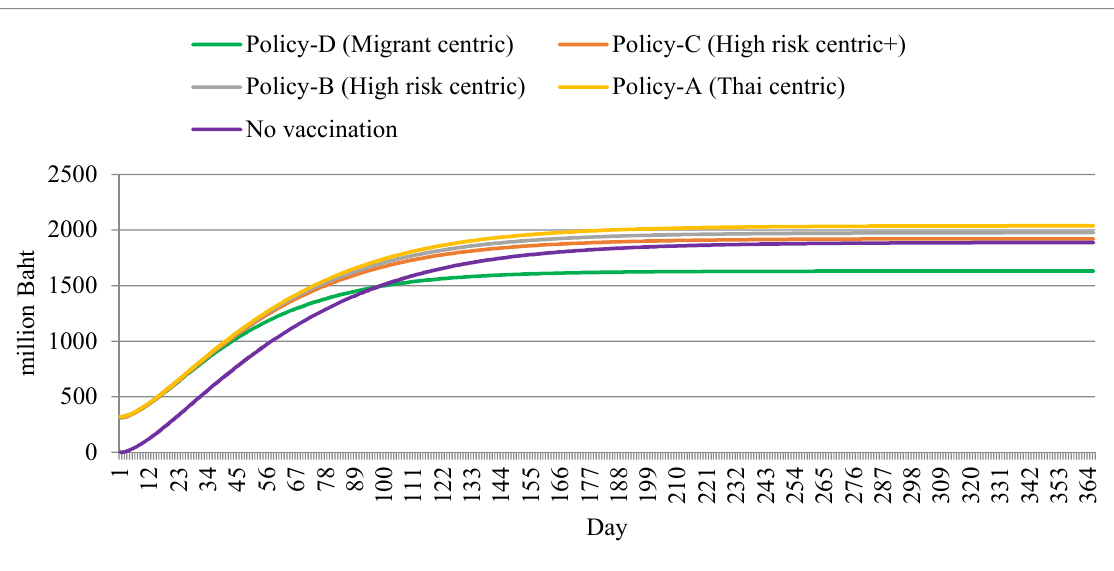
Figure 7. GDP loss by different policy scenarios. With reference to a no-vaccination policy, policy D appeared to be the best cost-sav- ing option. The incremental cost to save a life, prevent further cases, or resume one Baht of GDP includes a minus sign, denoting less cost invested with some benefits gained. Apart from policy D, policy C seemed to be the most cost-effective alternative (for in- stance, it cost 153,940 Baht per one life saved, almost ten times less costly than policy A). The incremental cost per one Baht GDP resumed in Policy A was expected to be 1.7 Baht, about double the corresponding cost for policy B and about eight-fold larger than policy C (see Table 6).